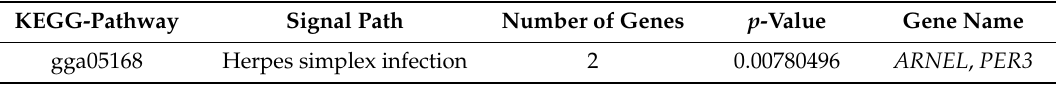
Table 9. The significantly enriched pathway of the four-week-old